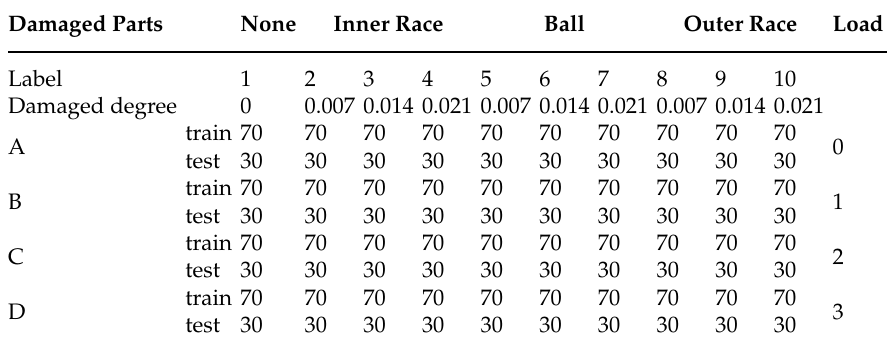
Table 1. Description of the experimental